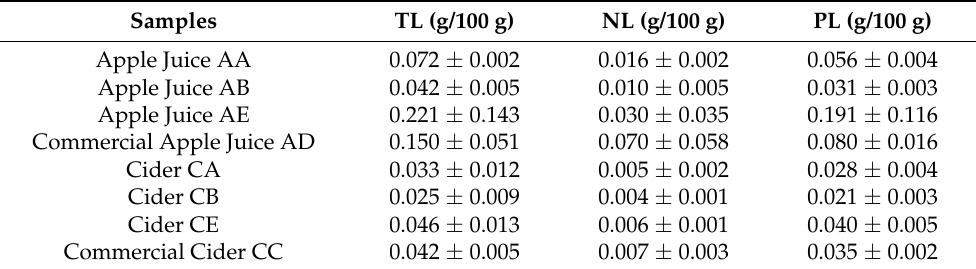
Table 2. The yield of extraction for the total lipids (TL), neutral lipids (NL) and polar lipids (PL) expressed as g/100 g of sample (mean ± SD, n =